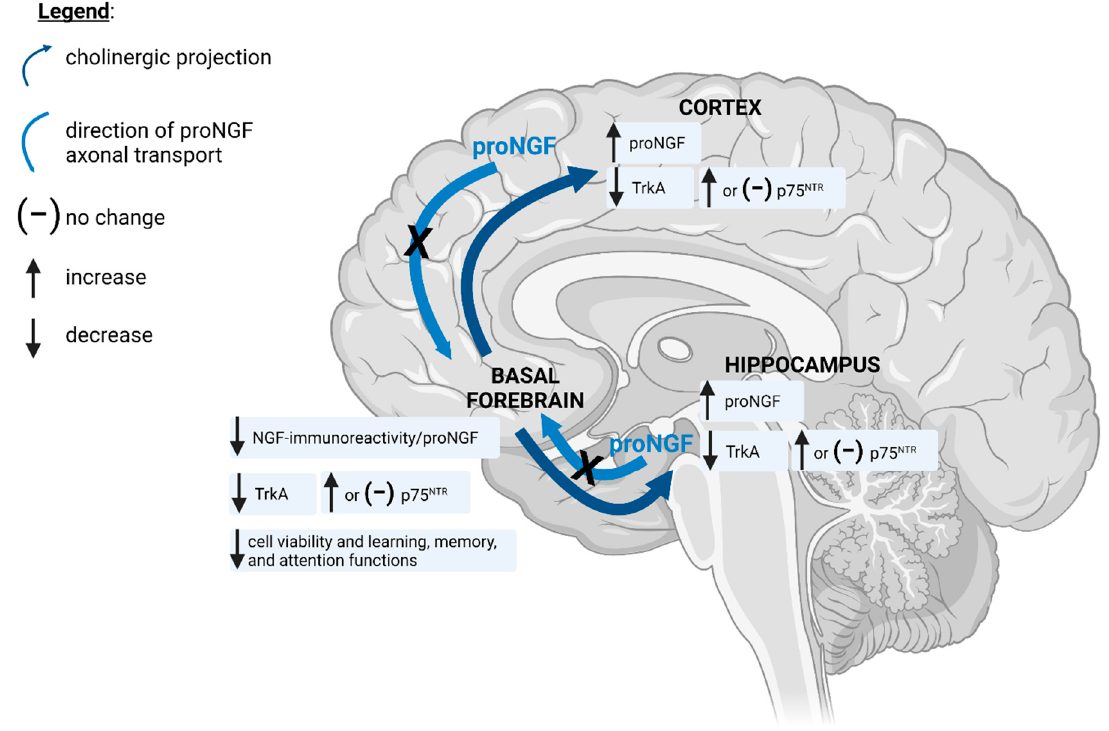
Figure 1. Alterations in proNGF distribution and receptor expression in aging and Alzheimer’s disease. Basal forebrain cholinergic neurons (BFCNs) send projections widely throughout the cortex and hippocampus. In the healthy brain, BFCNs receive neurotrophic support from these brain areas via retrograde transport of pro-nerve growth factor (proNGF). In aging and Alzheimer’s disease (AD), proNGF accumulates throughout the cortex and hippocampus, with accompanying